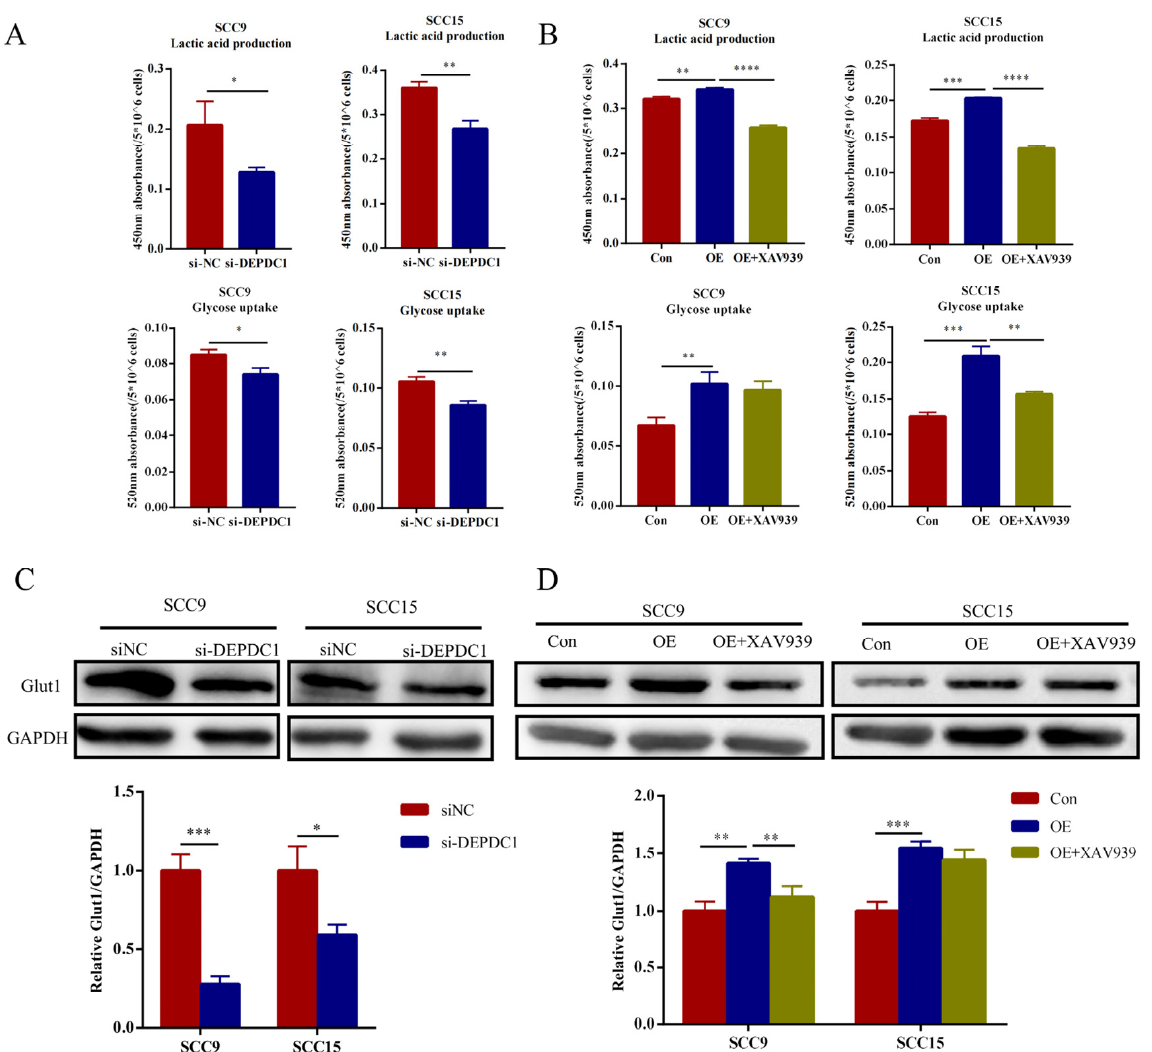
Figure 6. DEPDC1 promoted the aerobic glycolysis of OSCC. ( A ), Knockdown of DEPDC1 showed lower accumulation of lactate (SCC9 p = 0.0251, SCC15 p = 0.0023) and glucose uptake (SCC9 p = 0.0121, SCC15 p = 0.0035) in OSCC. ( B ), Lactic acid production (SCC9 p = 0.0051; p < 0.0001, SCC15 p = 0.0002; p < 0.0001) and glucose uptake (SCC9 p = 0.0067; p = 0.4904, SCC15 p = 0.0005; p = 0.0023) induced by DEPDC1 could be inhibited by XAV939. ( C , D ), Glut1 protein levels after knockdown (SCC9 p = 0.0004, SCC15 p = 0.0140) or overexpression (SCC9 p = 0.0013; p = 0.0072, SCC15 p = 0.0007; p = 0.1741) of DEPDC1 in SCC9 and SCC15. Con: control, OE: overexpression of DEPDC1. Significant differences were considered at p < 0.05 *; p < 0.01 **; p < 0.001 ***; and p < 0.0001 ****.